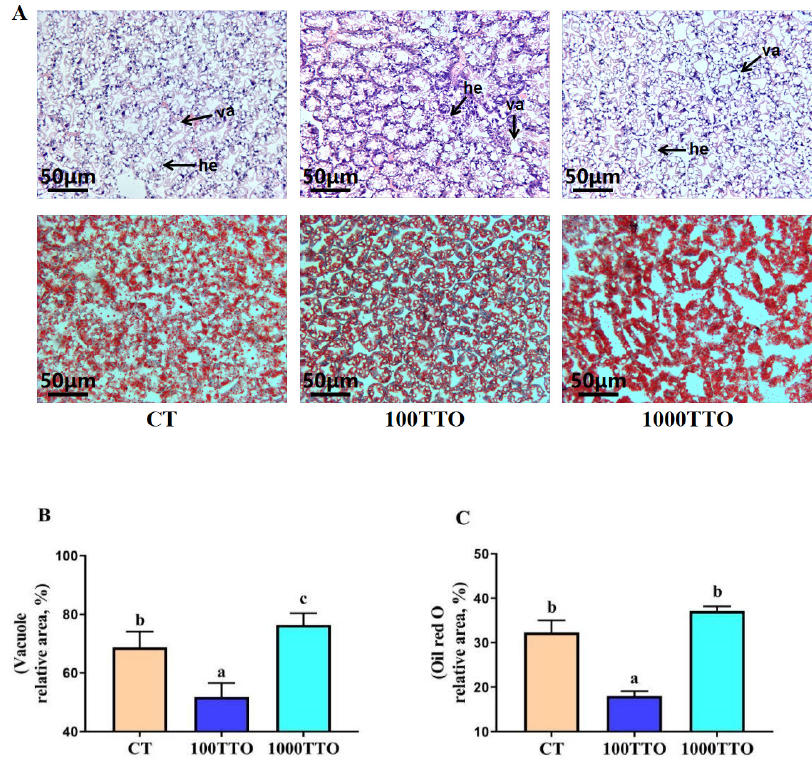
Figure 1. Effect of dietary TTO levels on morphology and lipid deposition in the hepatopancreas of M. rosenbergii . ( A ) The representative micrographs of H&E and Oil Red O ‐ stainings (200 × magnifi ‐